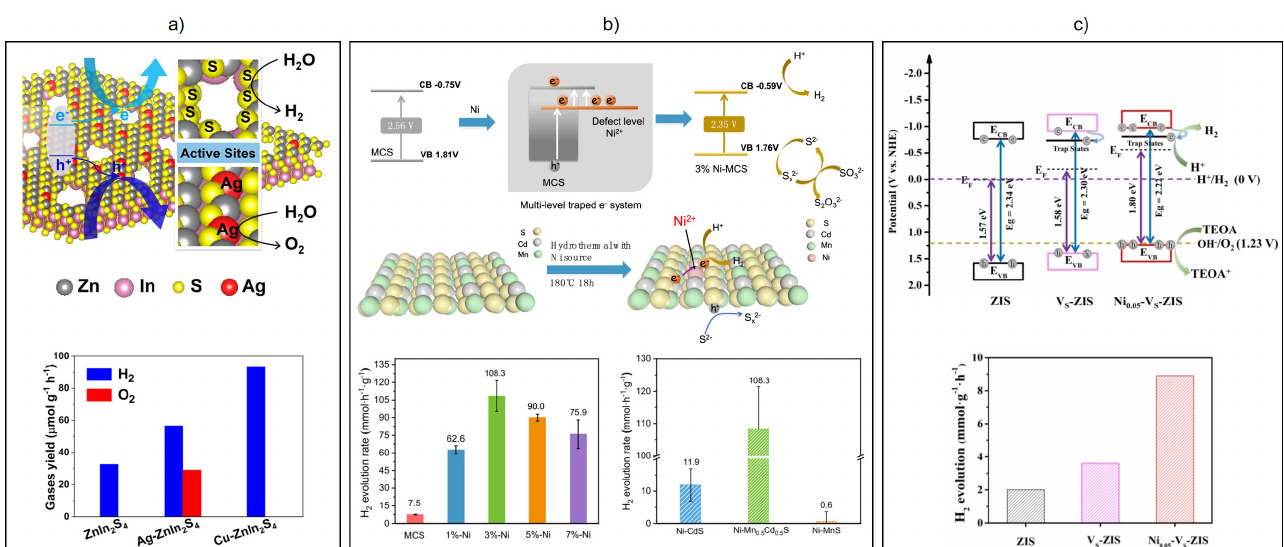
Figure 9. ( a ) Schematic illustration of the dual-defect (Ag dopants and nanoholes) configuration established on ZnIn 2 S 4 monolayers and their role in promoting O 2 and H 2 evolution reactions during photocatalytic water splitting [68]. Copyright 2021, American Chemical Society. ( b ) Schematic illus- tration for the H 2 evolution mechanism for 3% Ni doped Mn 0.5 Cd 0.5 S photocatalyst [73]. Copyright 2022, Wiley-VCH. ( c ) Schematic illustration of the band structure of ZIS, VS-ZIS and Ni 0.5 -VS-ZIS [74]. Copyright 2021, Wiley-VCH. The corresponding HER yields for each optimized photocatalyst are given in the bottom